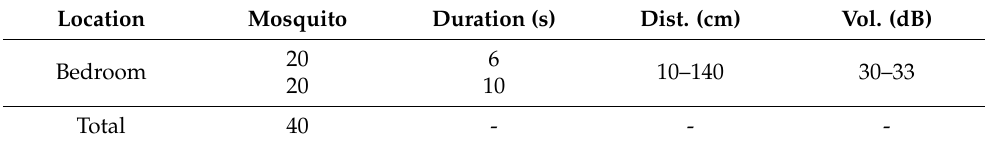
Table 5. Data set to test the target platform to classify Mosquito sound and noise.